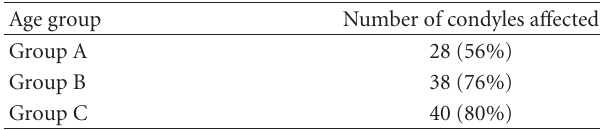
Table 2: Number of condyles a ff ected in each age group. Age group Number of condyles a ff ected Group A 28 (56%) Group B 38 (76%) Group C 40 (80%) ( P value 0.009) Chi square for trend. Table 3: Radiographic changes in condyles in three age groups. Condyles Group A Group B Group C Total Normal in both 9 3 14 (18.7%) Abnormal in right Abnormal in left Abnormal in both Abnormal in one or both